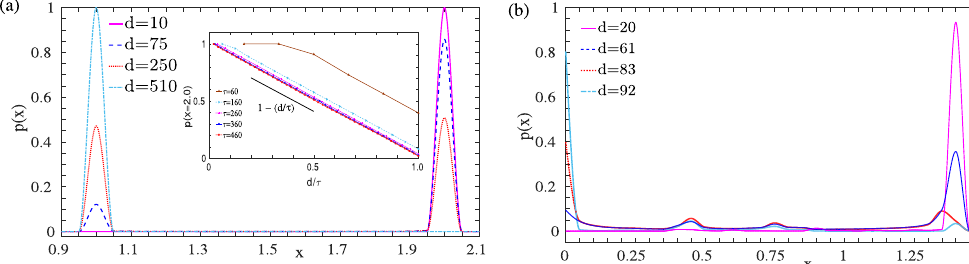
Figure 7. Probability of the concentration of any one transcription factor for different values of the drive time for ( a ) regime A with τ = 500. The inset shows the probability near one differentiated state ( x = 2) as a function of the ration of the drive to delay times d / τ ; and ( b ) regime B with τ =